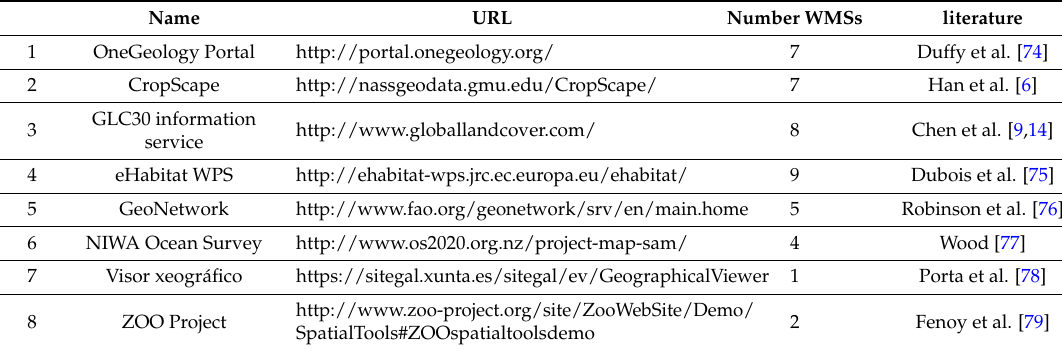
Table 4. The eight seed URLs used for the first